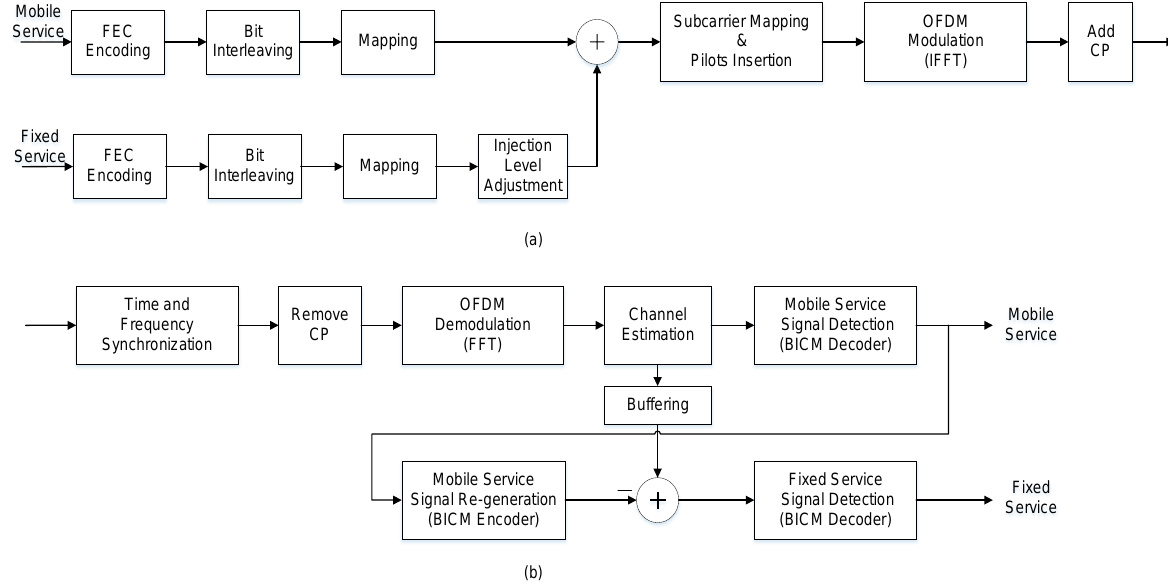
Figure 1. Block diagram of the traditional LDM system transceiver: ( a ) two-layer LDM transmitter; ( b ) two-layer LDM receiver.